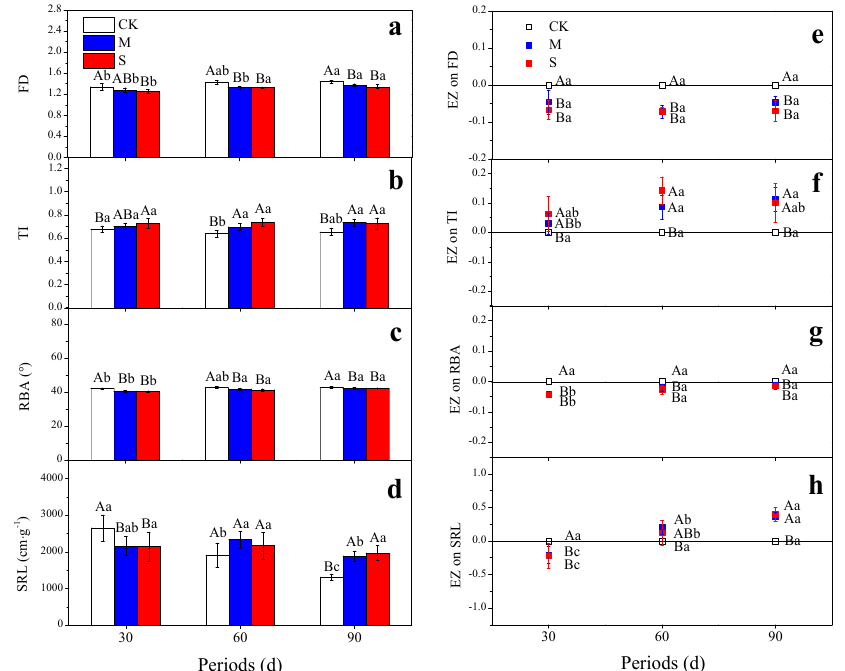
Figure 4. Effects of different drought treatments on fractal dimension ( a ), root topological index ( b ), root branching angle ( c ), specific root length ( d ), EZ on fractal dimension ( e ), EZ on root topological index ( f ), EZ on root branching angle ( g ), and EZ on specific root length ( h ) during different periods. The different capital letters denote significant differences between treatments ( p < 0.05), and the different lowercase letters denote significant differences between periods ( p < 0.05). EZ: effect size; FD: fractal dimension; TI: root topological index; RBA: root branching angle; SRL: specific root length. The histograms represent root architecture and SRL, and the scatter diagrams represent the EZ of drought treatments on root architecture and